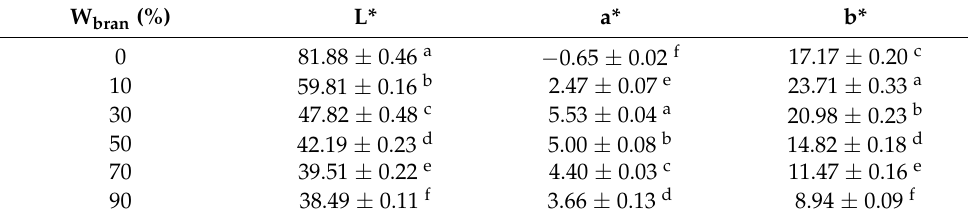
Table 6. Effect of W bran on the color difference of steamed bread.